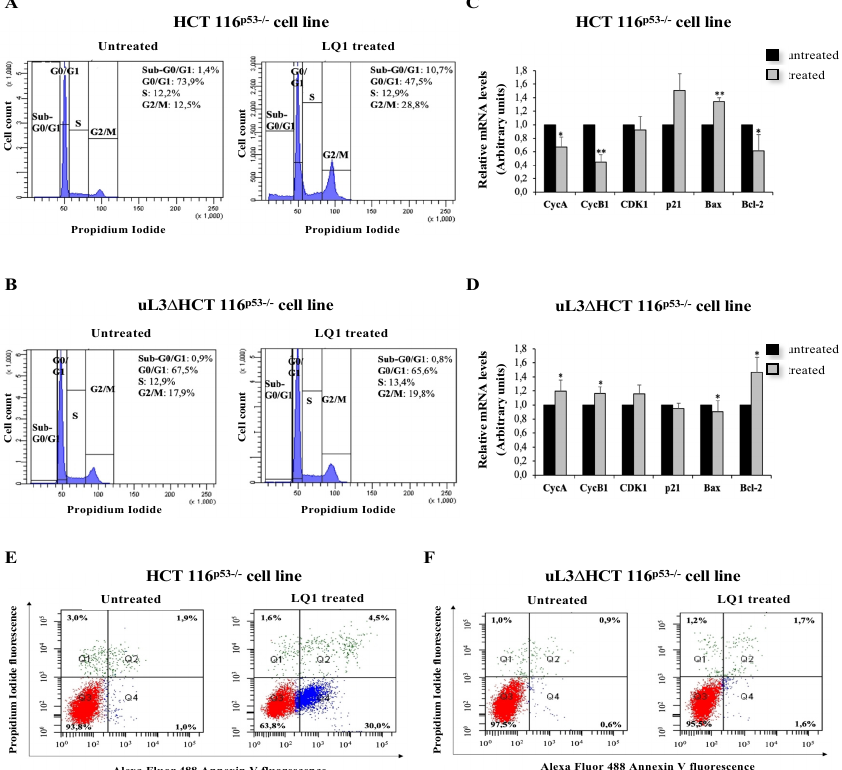
Figure 4. LQ1 treatment leads to cell cycle arrest and induces early apoptosis in colon cancer cells. HCT 116 p53 − / − ( A ) and uL3 Δ HCT 116 p53 − / − ( B ) cells were incubated with 10 µM of LQ1 for 48 h, and the cell cycle distribution was evaluated using PI staining and flow cytometry analysis. Total RNA